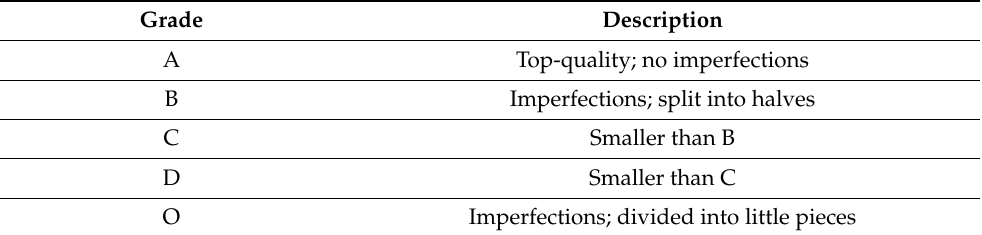
Table 1. Processed jellyfish grades. Grade Description A Top-quality; no imperfections B Imperfections; split into halves C Smaller than B D Smaller than C O Imperfections; divided into little